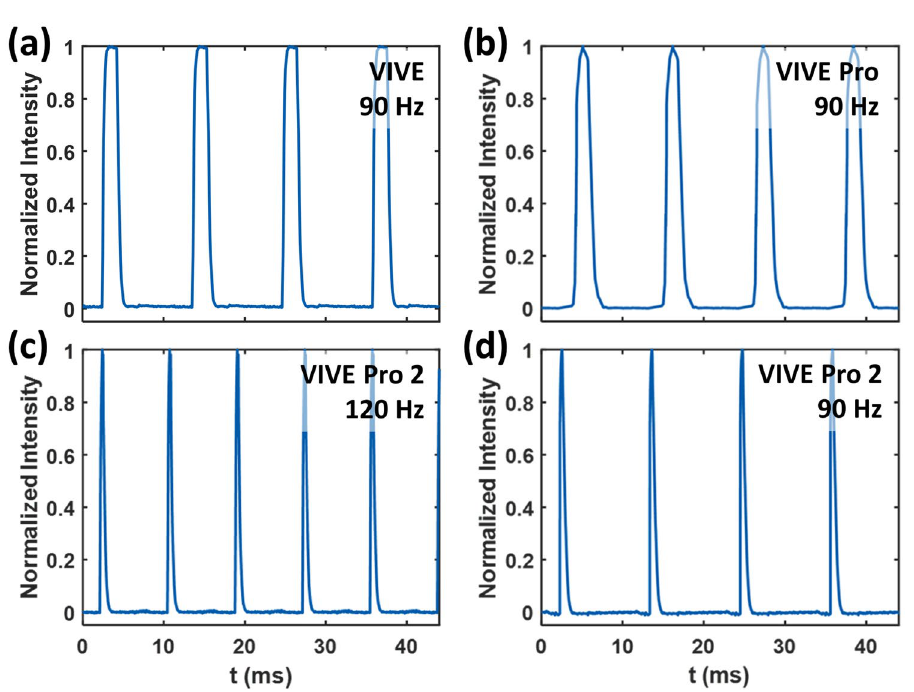
Figure 6. Temporal responses of ( a ) the VIVE at 90 Hz, ( b ) the VIVE Pro at 90 Hz, ( c ) the VIVE Pro 2 at 120 Hz, and ( d ) the VIVE Pro 2 at 90